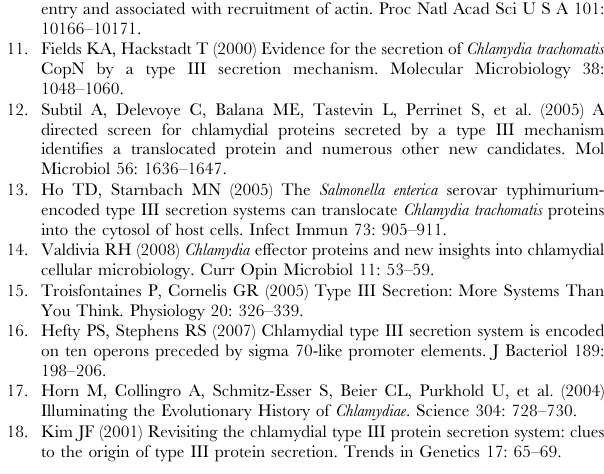
Figure S1 Mcsc structural models. A–C. Predicted three dimensional structure of Mcsc. A putative 3D model of Mcsc (yellow) was generated with the neural network folding prediction program I-TASSER (http://zhang.bioinformatics.ku.edu/I-TAS- SER/) [1]. Modeling of Mcsc and SigE structure were performed with PyMOL (http://www.pymol.org/). Overlay of Mcsc mono- mers (A) on SigE (magenta) monomers and dimers (blue) (B), and a model of a Mcsc dimer (C). D. Conservation among amino terminal residues in Class I T3S chaperones required for effector protein binding. Conserved amino acids (blue) in Mcsc align with a -helix and b -strand 1 as assessed by secondary structure predictions performed with PSIPRED (http://bioinf.cs.ucl.ac.